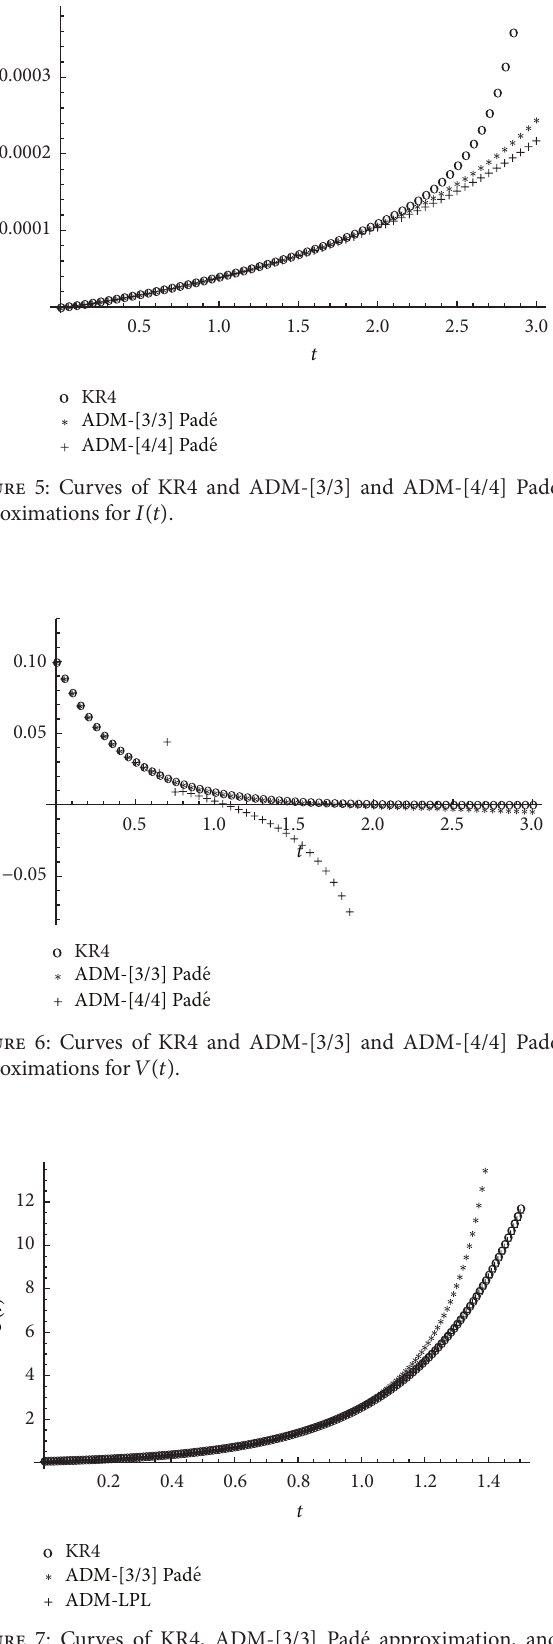
Figure 7: Curves of KR4, ADM-[3/3] Pad´e approximation, and ADM-LPL for 𝑇(𝑡) .